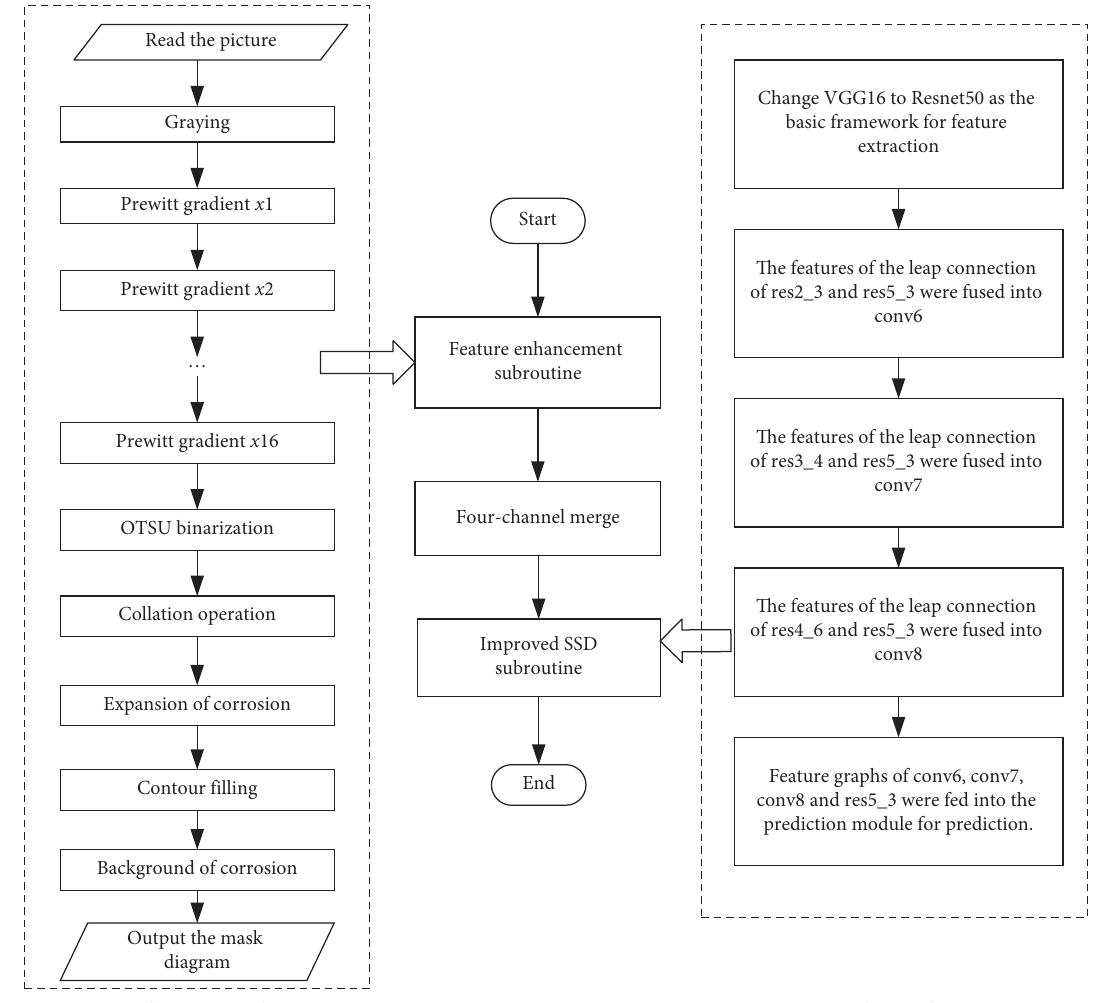
Figure 6: Underwater image detection flow